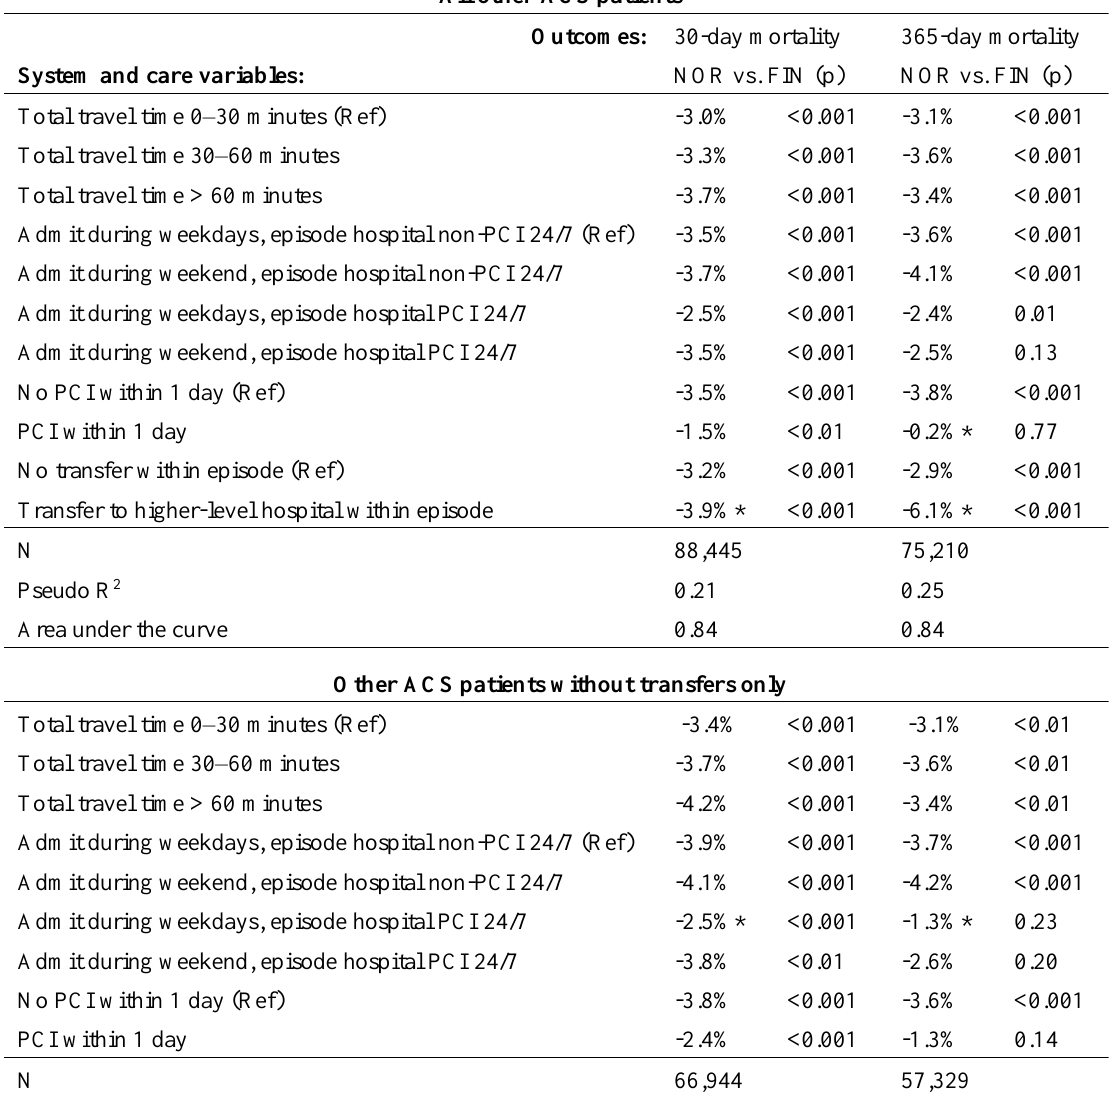
Marginal mortality differences in percentage points, Norway (NOR) vs. Finland (FIN) and p-values (p), for different categories of system and care variables for the other ACS patients All other ACS